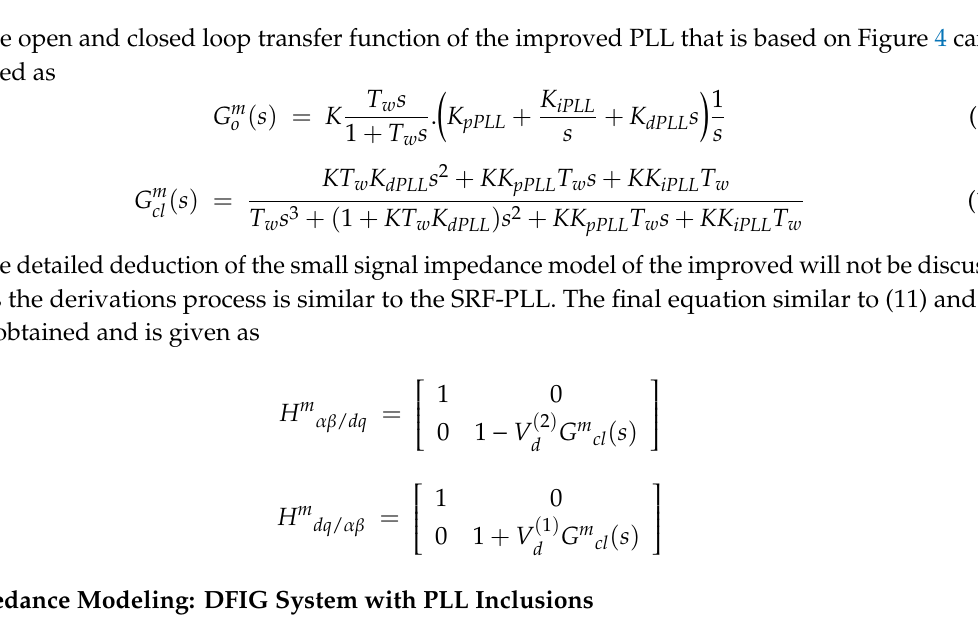
Figure 4. Schematic diagram of improved PLL.